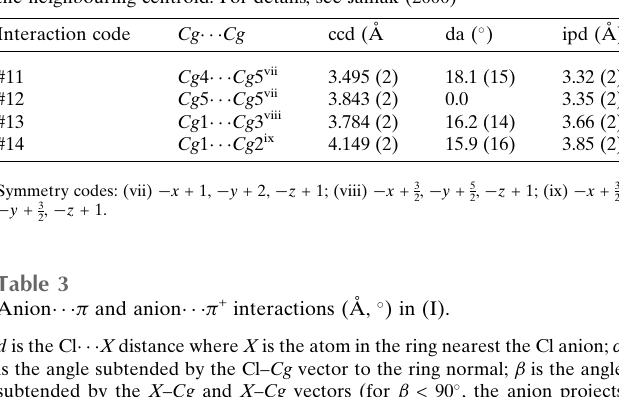
Table 2 (cid:2) – (cid:2) contacts in (I). Ring codes as in Fig. 1. ccd: centroid-to-centroid distance; da: dihedral angle between rings; ipd: interplanar distance, or (mean) distance from one plane to the neighbouring centroid. For details, see Janiak (2000)